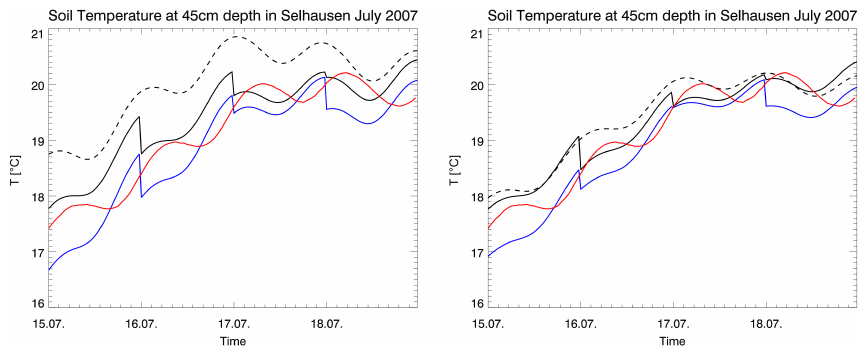
Figure 1. Soil temperature in Selhausen for 15 to 18 July 2007 at 45cm depth. The black dashed curve shows the control run, the black solid curve shows the CLM forecast based on the analysis of the previous day, while the blue curve depicts the analysis. Measurement values are shown as a red line. The left panel shows results for the original soil composition, containing 13% sand and 17% clay. The right panel shows the respective results for a soil containing 5% sand and 25%